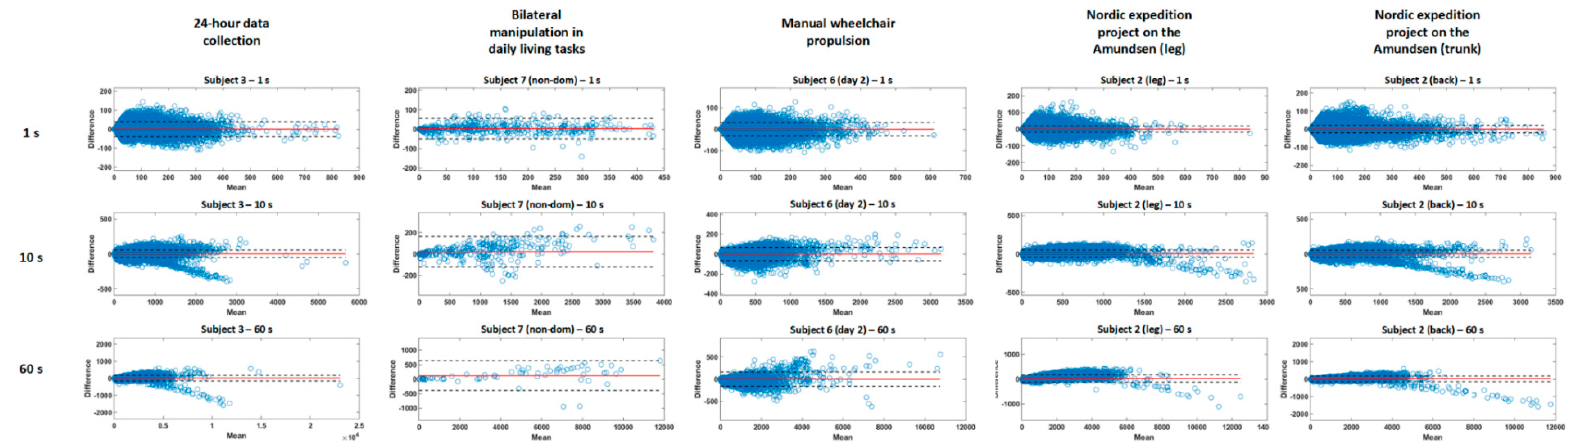
Figure 6. Bland–Altmann plot for a representative subject for each project at an epoch of 1 s, 10 s and 60 s for the modifiable bandwidth algorithm. A B